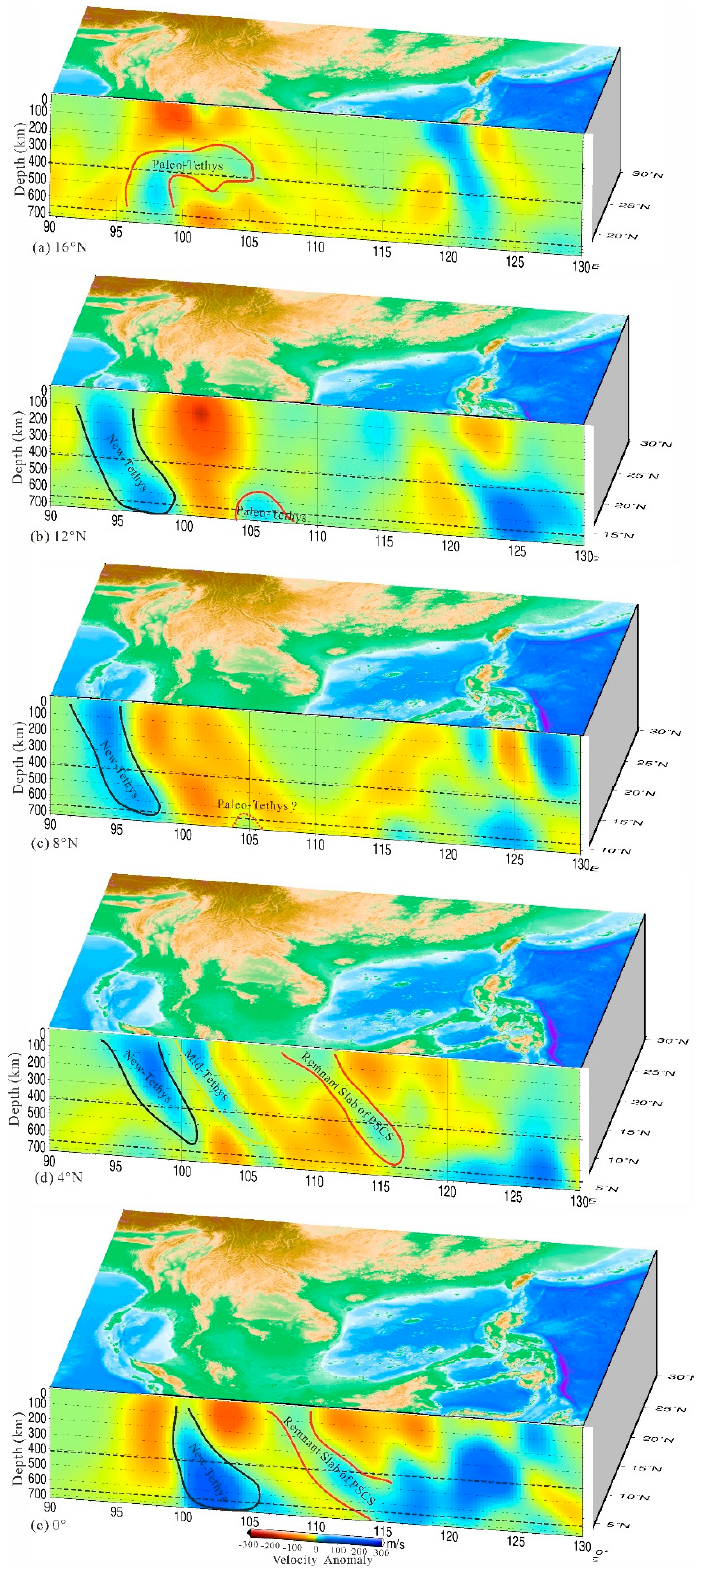
Figure 12. Five vertical slices of the P-wave velocity tomography along the latitude direction. (a) Vertical slice along 16°N; (b) Vertical slice along 12°N; (c) Vertical slice along 8°N; (d) Vertical slice along 4°N; (e) Vertical slice along 0°N. Red color and blue color represent low and high velocity anomalies, respectively. The two dashed lines in the slices indicate the 410 and 660 km discontinuities, respectively. The velocity anomaly scale is shown at the bottom.